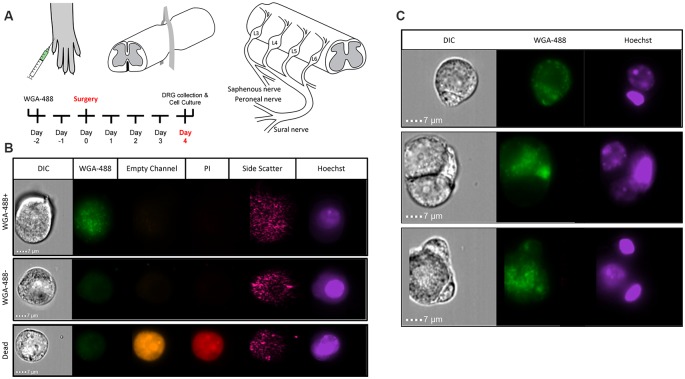
Identifying sensory neurons. (A) Diagram of WGA-488 injection under the hairy hindpaw skin of a mouse, how the SCI was conducted with a vessel clip, and projections to the corresponding dorsal root ganglia (DRG). (B) Fluorescent cell images taken by Amnis ImageStreamX Mark II imaging flow cytometer (Luminex Corporation, Austin, TX, USA) using a 60x objective lens with excitation from a 405 nm laser and a 488 nm laser to identify propidium iodide (PI; red) positive (dead) cells and WGA (green) labeled cells, respectively. (C) Sample images of rejected cells because of attachment to non-nociceptor cells. Similarly, nociceptors with attached PI+ debris were eliminated.